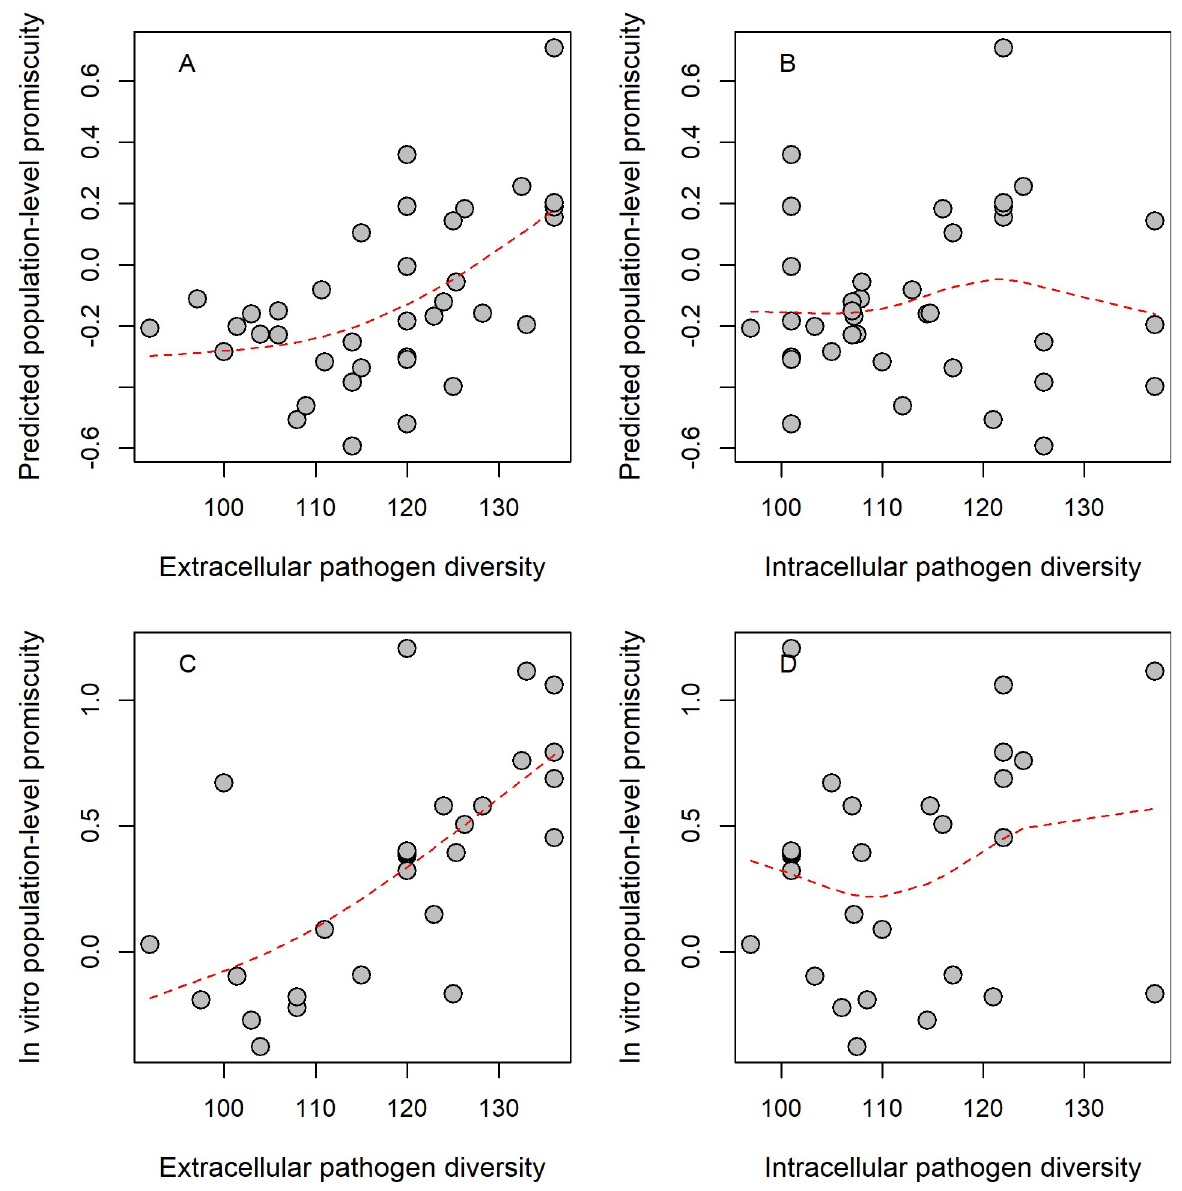
Fig 1. Relationship between epitope-binding promiscuity and pathogen diversity. Normalized population-level promiscuity of HLA-DRB1 alleles is shown as the function of extracellular pathogen diversity, as approximated by species count. Promiscuity scores were calculated based on standardized (i.e., z-score) allele promiscuity values and were averaged in each population group (see Methods). Significant correlations were found between extracellular pathogen species count and (A) predicted allele promiscuity level in 37 groups (Spearman’s rho: 0.5, P = 0.002) and (C) in vitro promiscuity level in 28 groups (Spearman’s rho: 0.7, P = 3 � 10 − 5 ). No significant correlation was found between intracellular pathogen diversity and (B) predicted and (D) in vitro promiscuity at the HLA-DRB1 locus (Spearman’s rho: 0.04 and 0.21, P = 0.81 and 0.29, respectively). Dashed lines indicate smooth curve fitted using cubic smoothing spline method in R (see Methods). Population groups were created using the 15th percentile genetic distance cutoff (see Methods). For results obtained upon using alternative distance cutoff values, see S3 Data. The underlying data for this figure can be found in S4